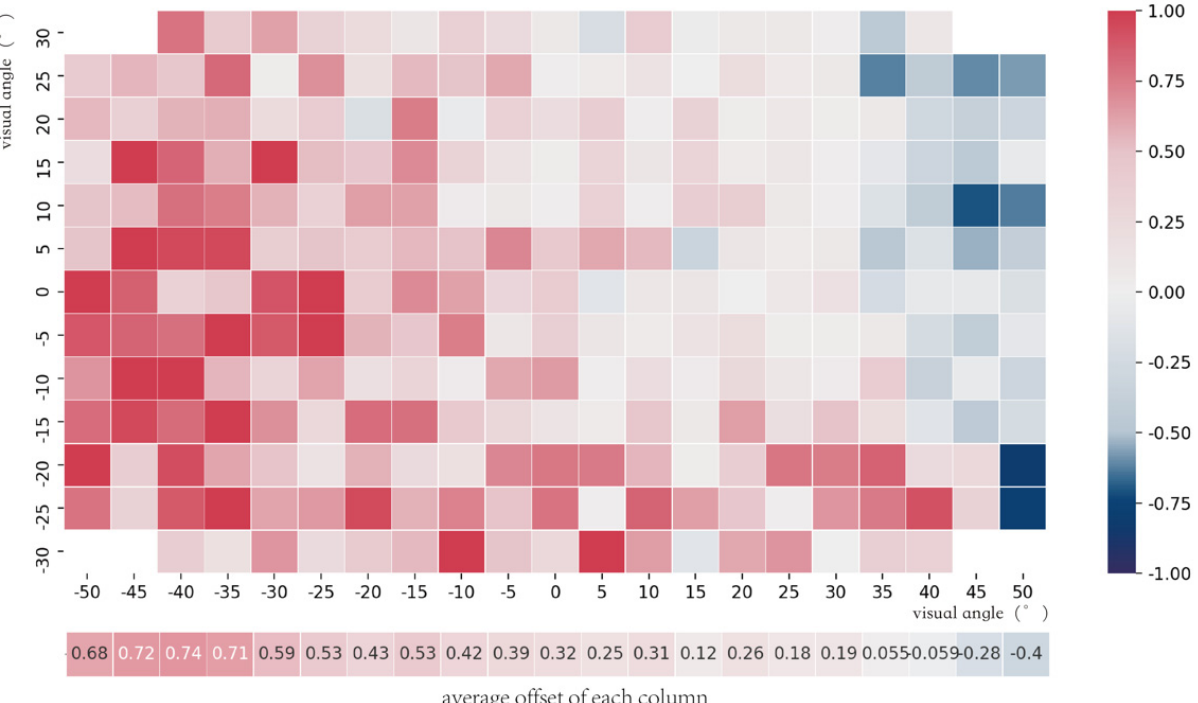
Figure 8. Heat map of the center click offset in the horizontal direction .